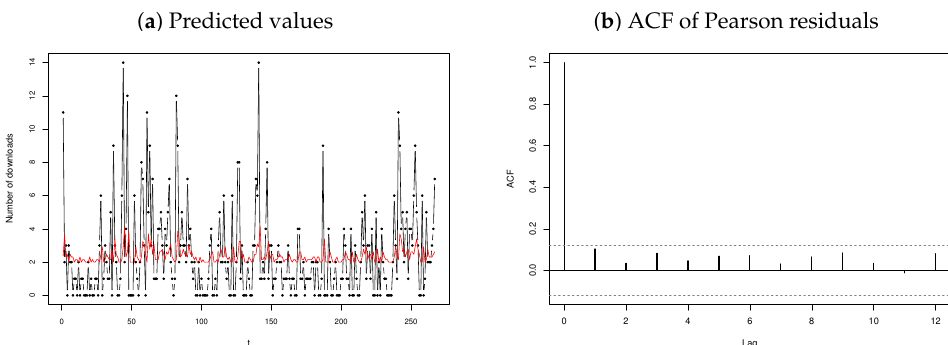
Figure 9. Predicted values (in red) and Pearson residuals’ ACF for the download data.